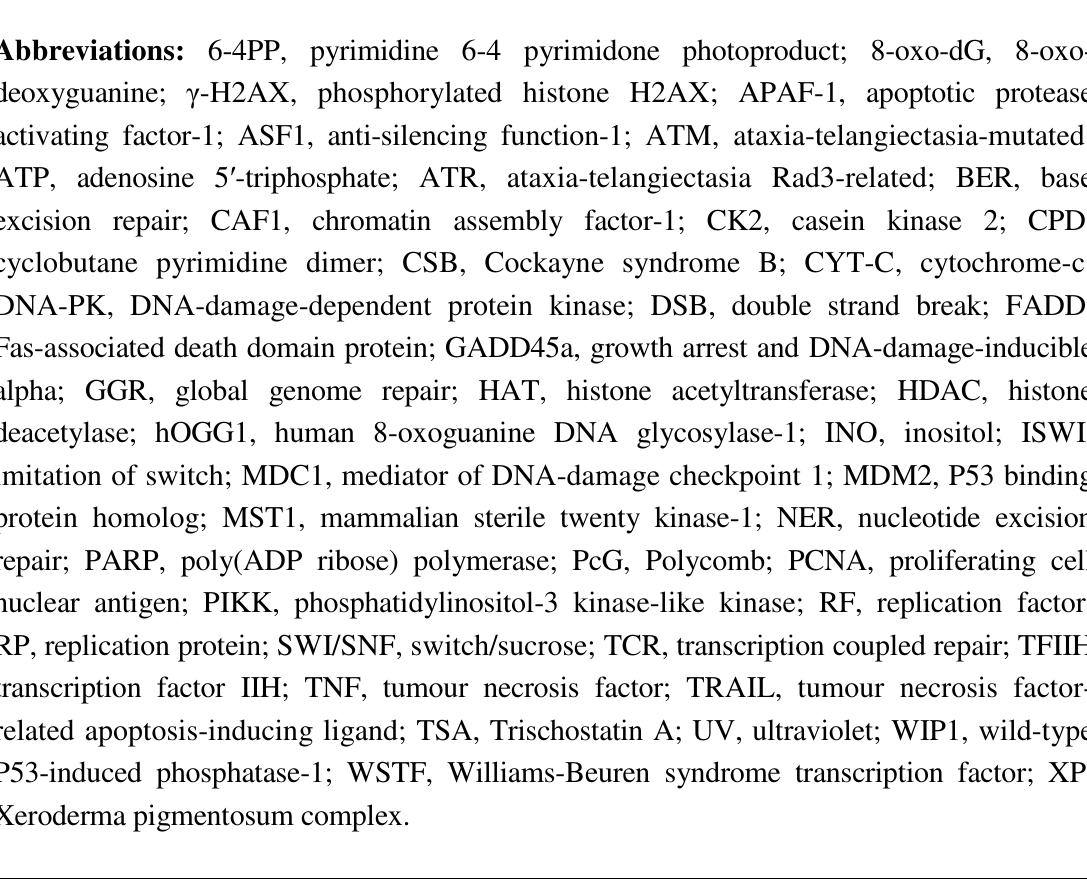
Abbreviations: 6-4PP, pyrimidine 6-4 pyrimidone photoproduct; 8-oxo-dG,